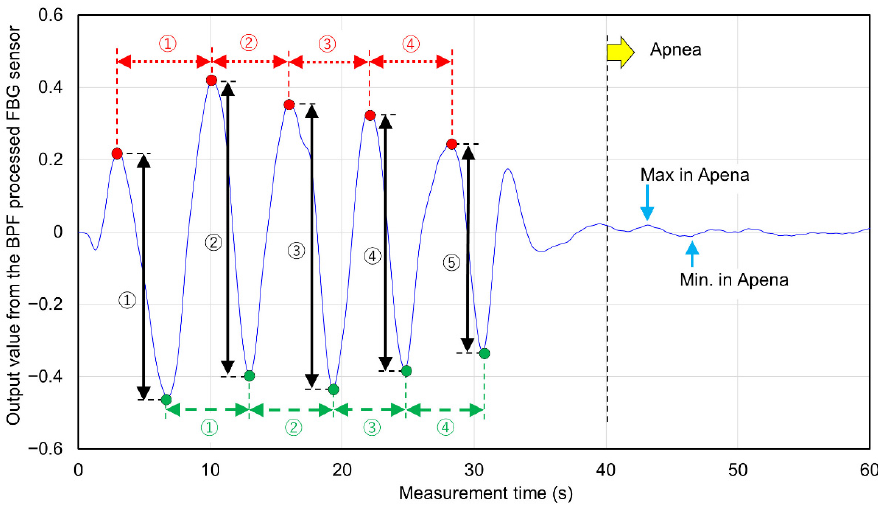
Figure 5. Analysis method of signals measured by FBG sensor.